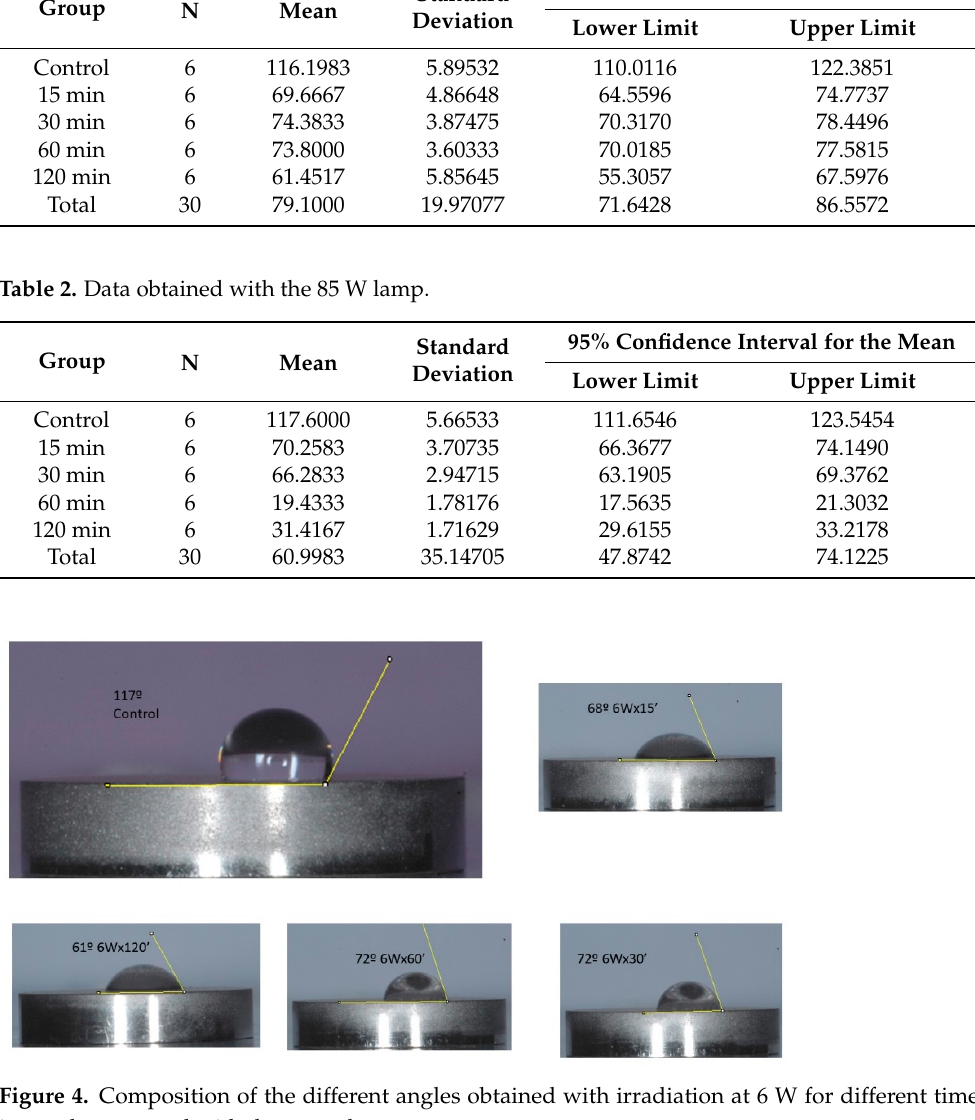
Figure 5. Composition of the different angles obtained with irradiation at 85 W for different time intervals compared with the control.